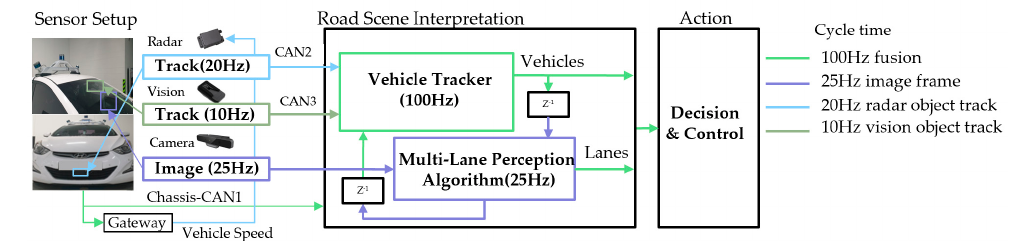
Figure 3. The multi-rate and multi-sensor fusion flow chart.